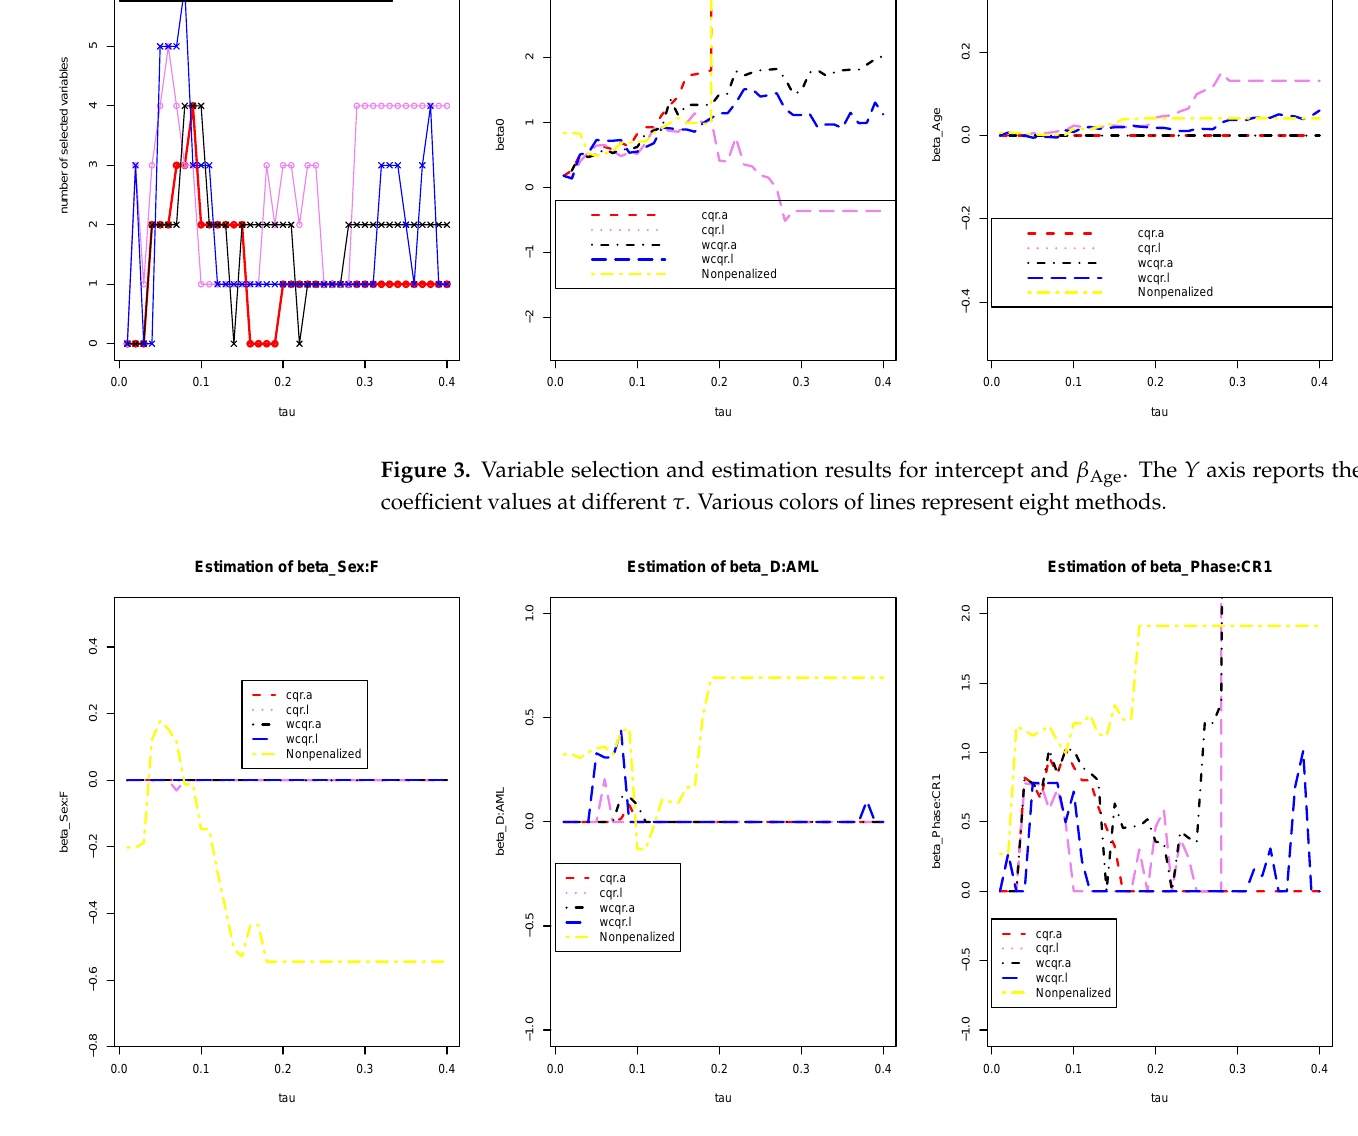
Figure 4. Estimation results for β Sex:F , β D:AML , and β Phase:CR1 .The Y axis reports the coefficient values at different τ . Various colors of lines represent eight